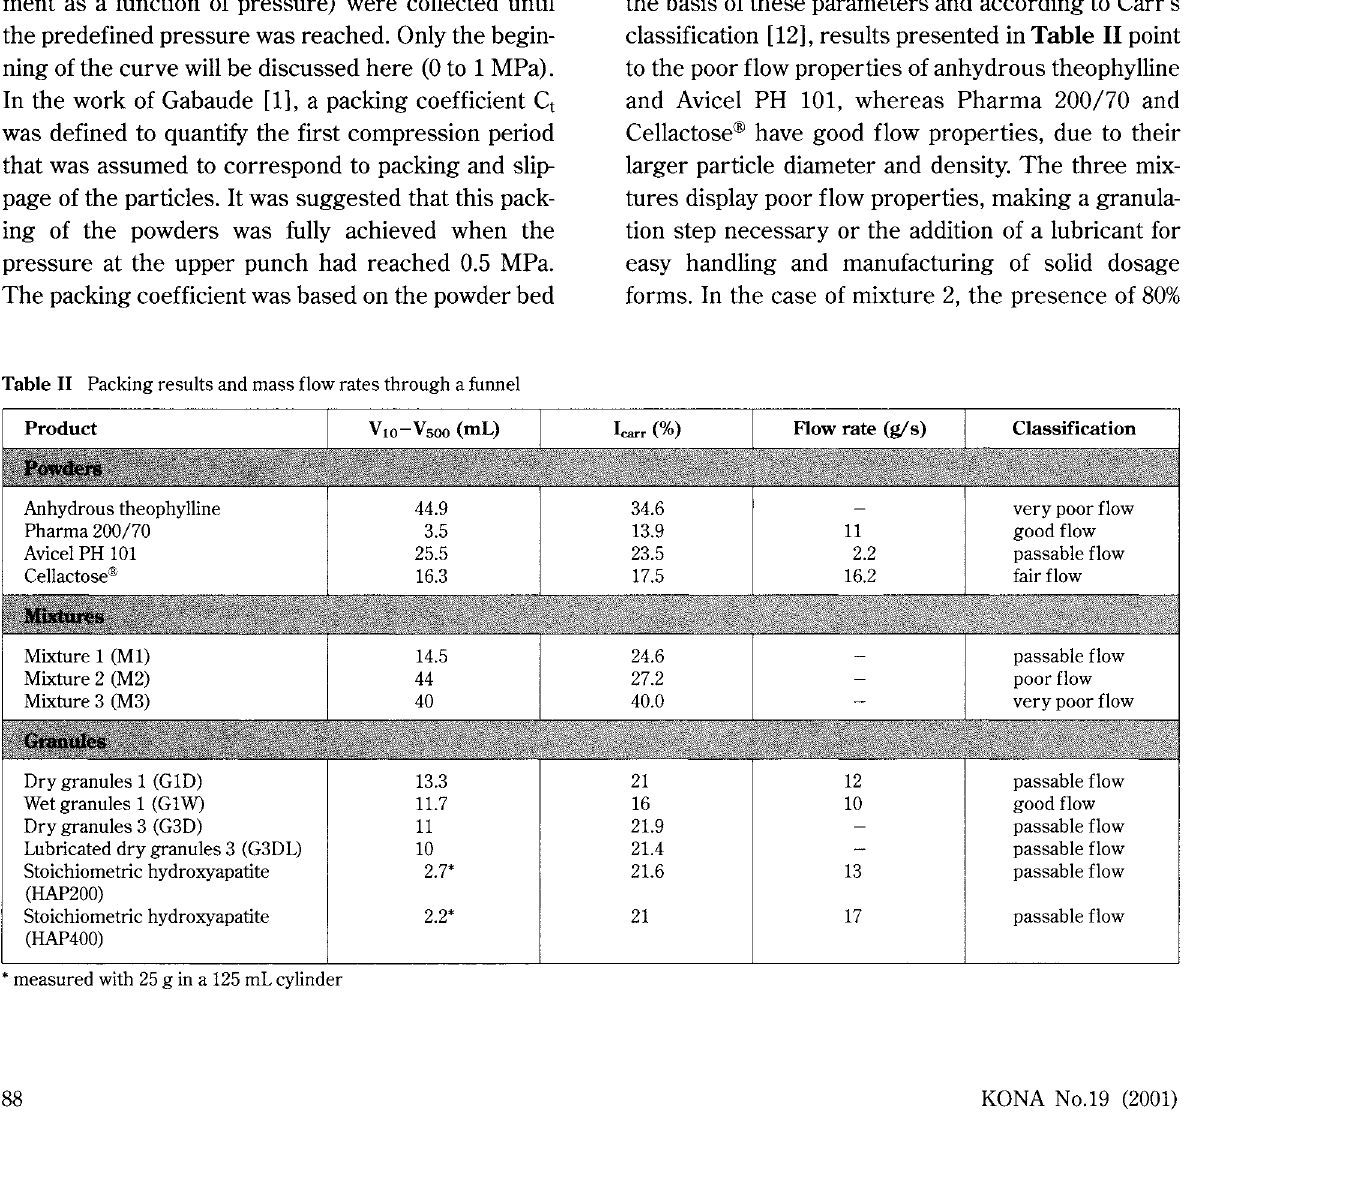
pressure at the upper punch had reached 0.5